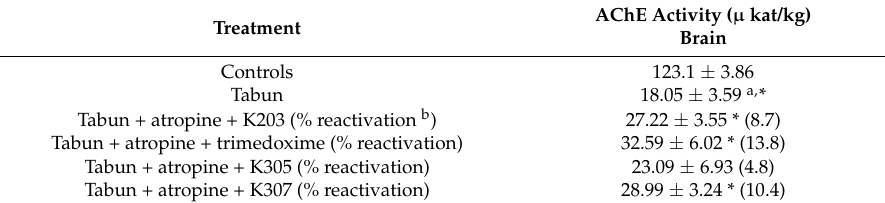
Table 3. Percentage of reactivation of tabun-inhibited AChE by oximes in rat brain in vivo.